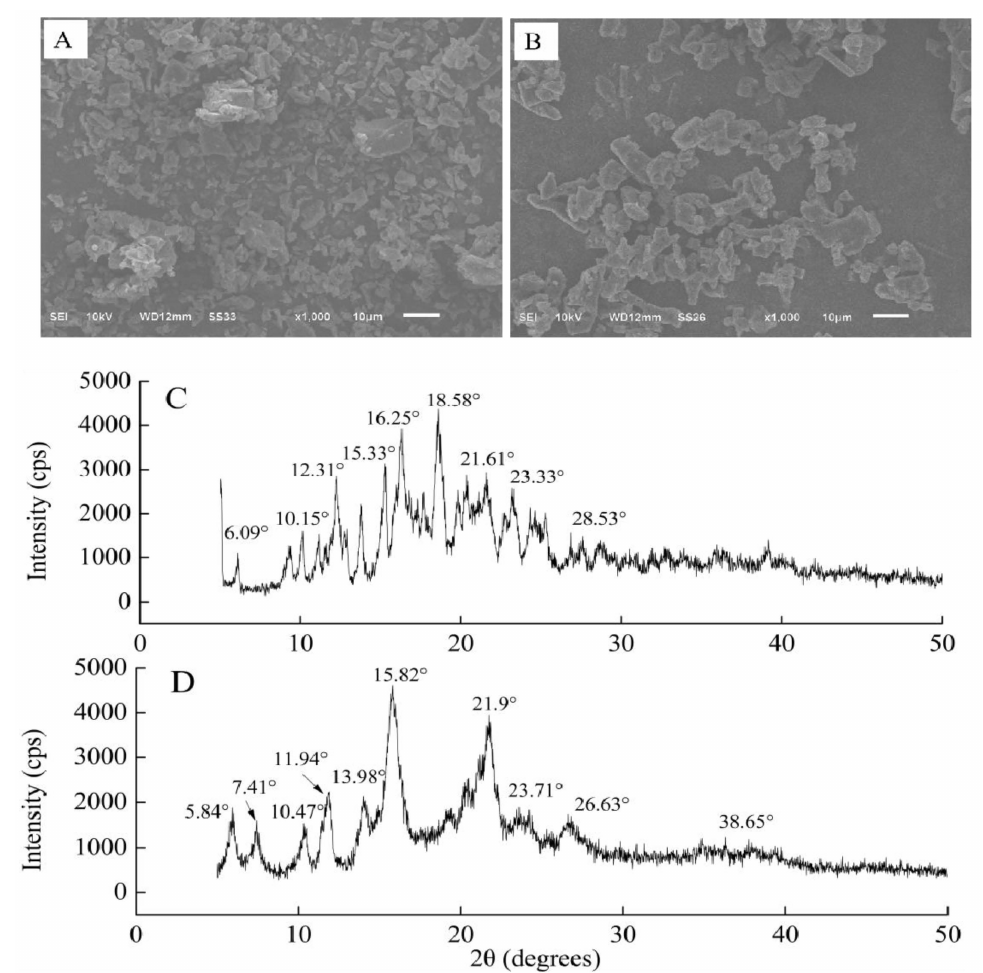
Figure 2. SEM graphs of γ -CD ( A ), γ -CDCL ( B ); and XRD patterns of γ -CD ( C ), γ -CDCL ( D ); SEM, scanning electron microscopy; XRD, X-ray diffraction; γ -CD, γ -cyclodextrin; γ -CDCL, cinnamaldehyde/ γ -cyclodextrin inclusion complex.